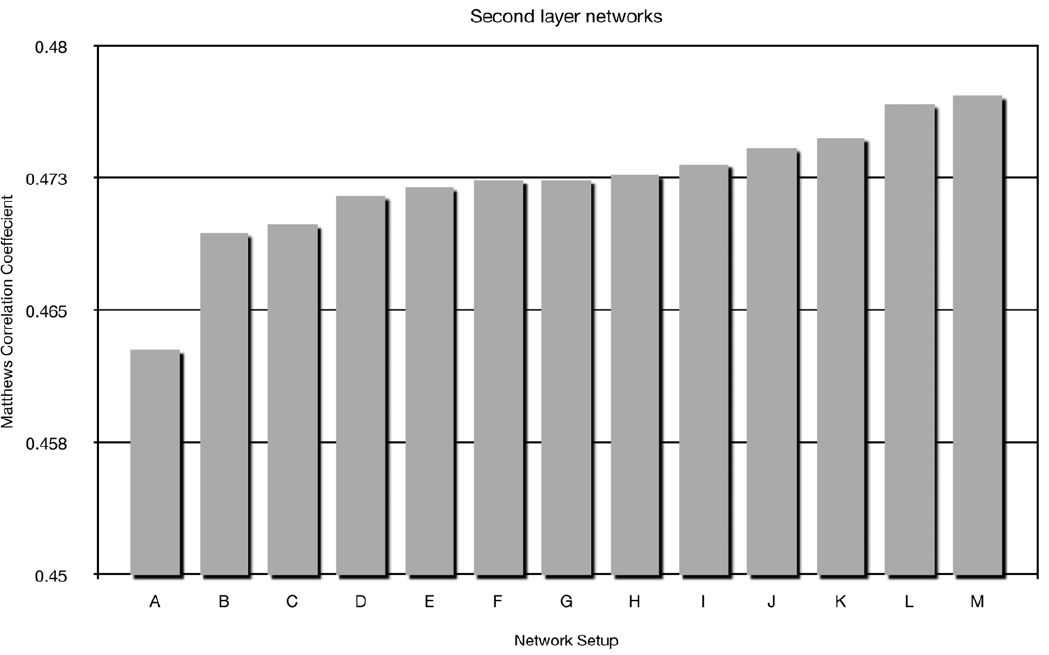
Figure 2. Test MCC performance on the Cull-2220 dataset, for different setups of the second level network. The performance is the average from an ensemble of 10 network architectures for each setup. Abbreviations for the setups are as follows: b -turn-P = position specific first layer predictions, b -turn-G = general b -turn/not- b -turn first layer predictions, sec-rsa = secondary structure and surface accessibility predictions from NetSurfP [28], PSSM = Position Specific Scoring Matrices. The setups are composed as follows: A= PSSM + sec-rsa, B=PSSM + b -turn-G + sec-rsa, C= PSSM + b -turn-G, D= PSSM + b -turn-P, E= b -turn-P, F= b -turn-G + sec-rsa, G= b -turn-G, H= PSSM + b -turn-P + sec-rsa, I= b -turn-P + sec-rsa, J= PSSM + b -turn-P + b -turn-G + sec-rsa, K= PSSM + b -turn-P + b -turn-G, L= b -turn-P + b -turn-G, M= b -turn-P + b -turn-G +